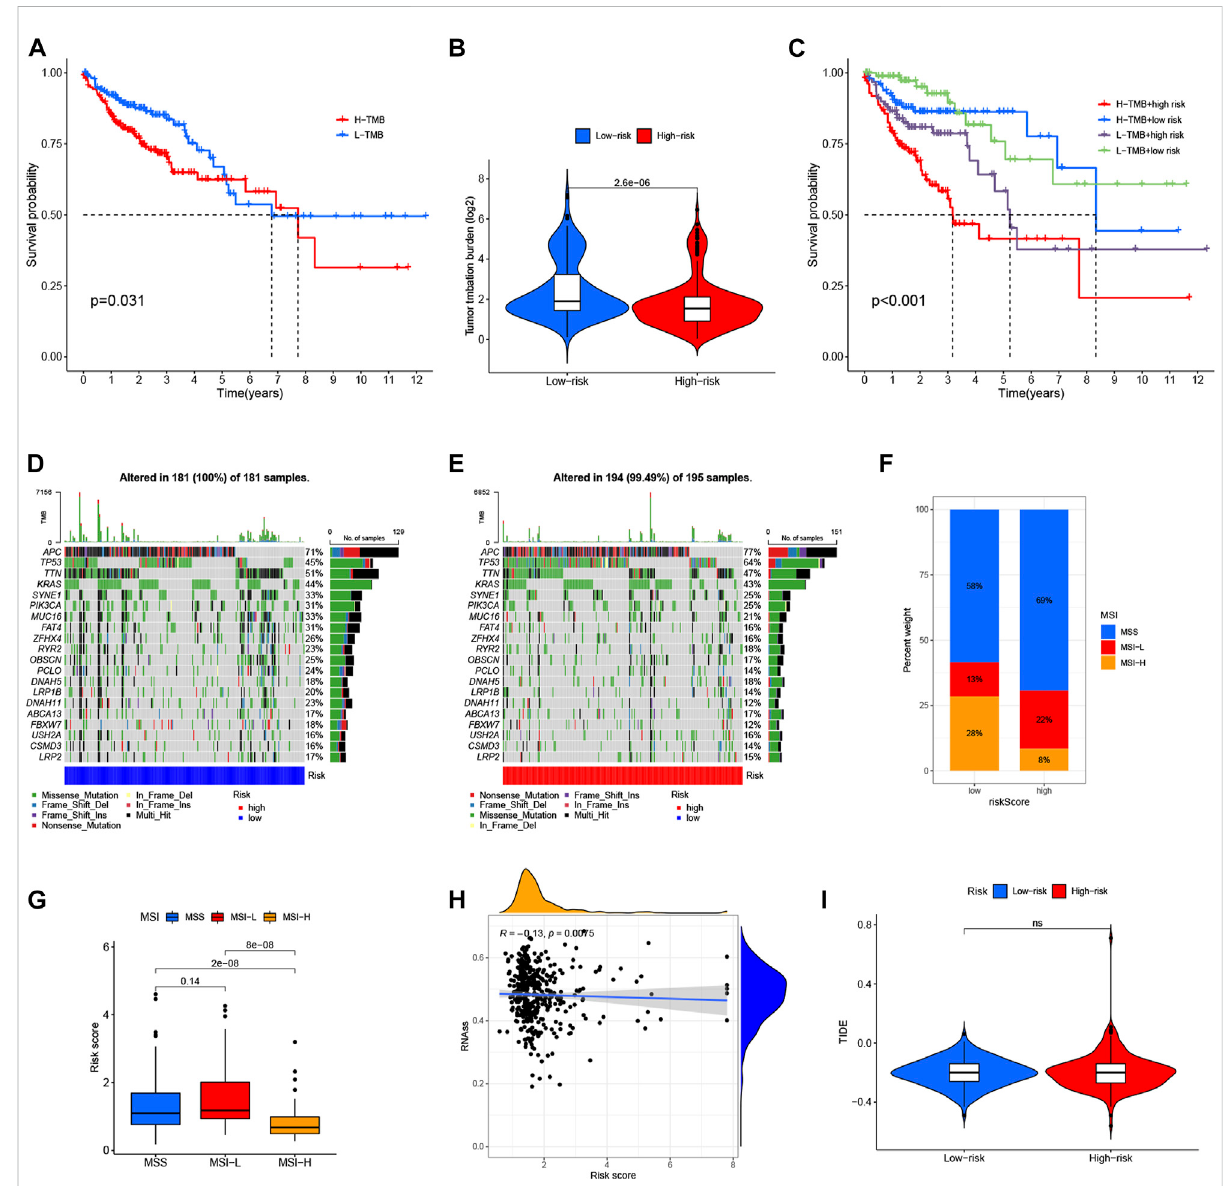
two risk groups and